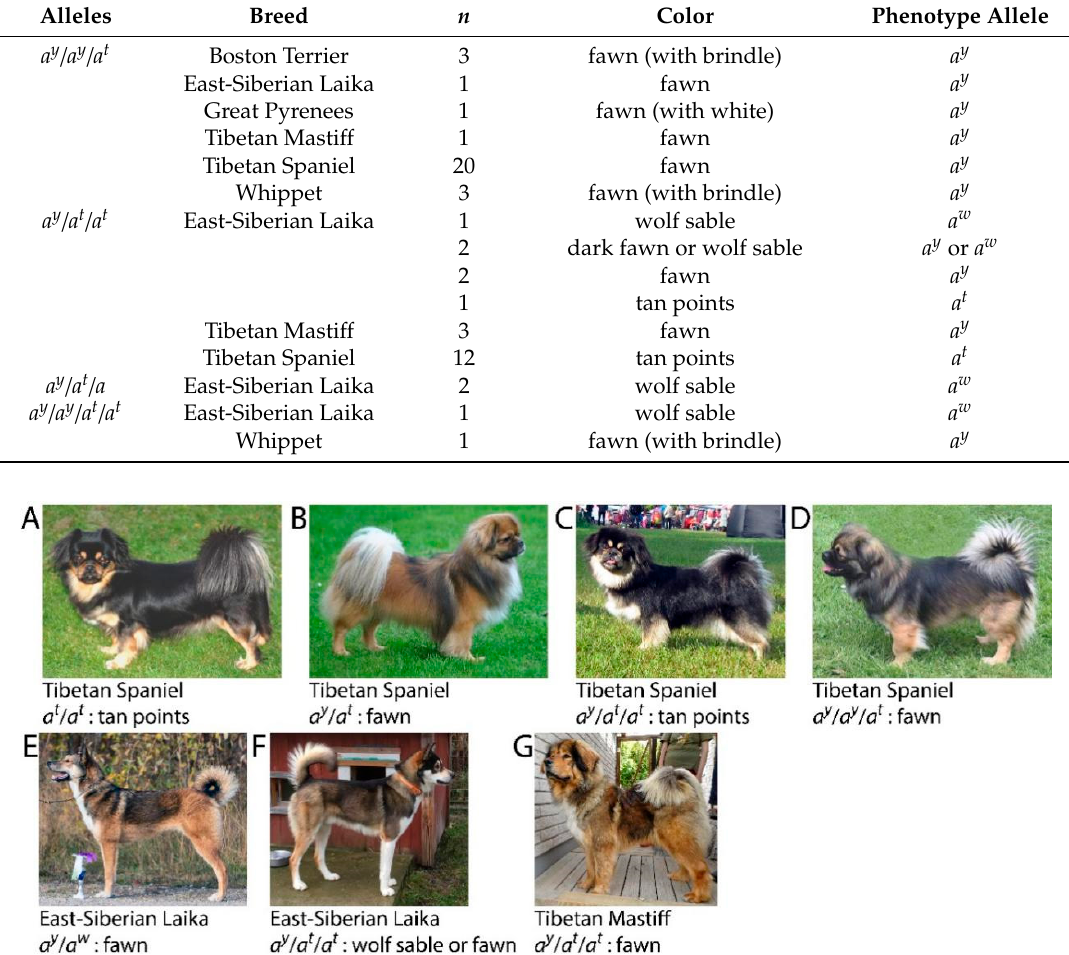
Figure 1. Conventional and A 3+ ASIP genotype-phenotype combinations. ( A – D ) Tibetan Spaniels routinely express a tan point phenotype ( A ), produced by homozygous a t alleles, and a fawn phenotype ( B ), produced with a dominant a y allele. When genotyped as A 3+ ( C , D ), the allele that is present twice will dictate the phenotype. East-Siberian Laikas ( E , F ) possess all four known ASIP alleles naturally. The dominant a y allele produces a fawn phenotype ( E ), while an East-Siberian Laika genotyped as a y / a t / a t ( F ) could be a y fawn or a w wolf sable. In Tibetan Mastiffs ( G ) with a y /a t /a t , a fawn phenotype is expressed, a different pattern than that seen in Tibetan Spaniels ( C ).